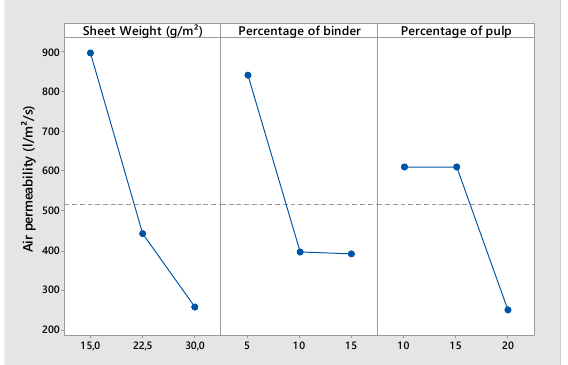
Figure 4. Main effects plot for air permeability.